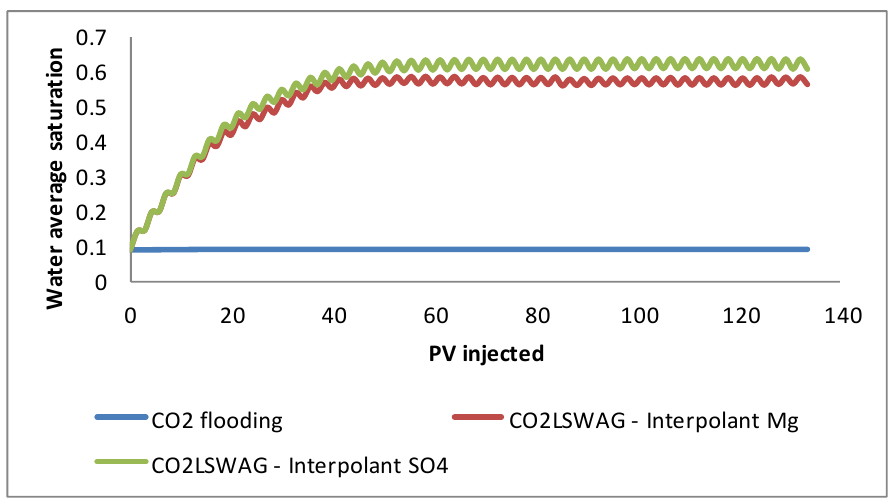
Figure 9. Water average saturation for continuous CO 2 injection and CO 2 -LSWAG considering Mg and SO 4 as ion interpolants.